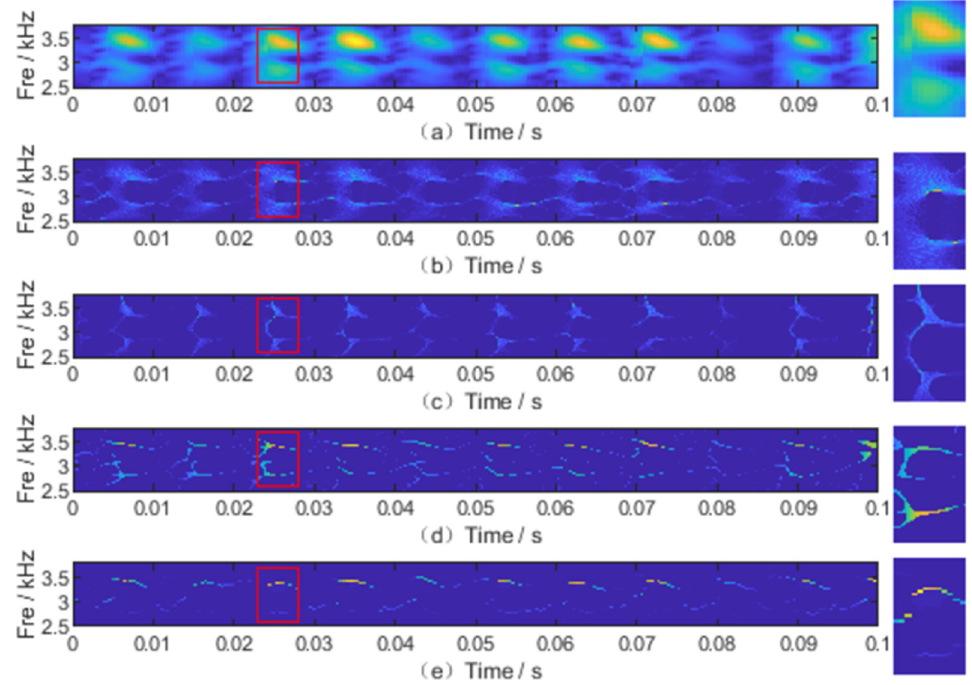
Fig 13. TFA results obtained by(a)SBCT, (b)SST, (C)RM, (d)SET, (e) LMSBCT.